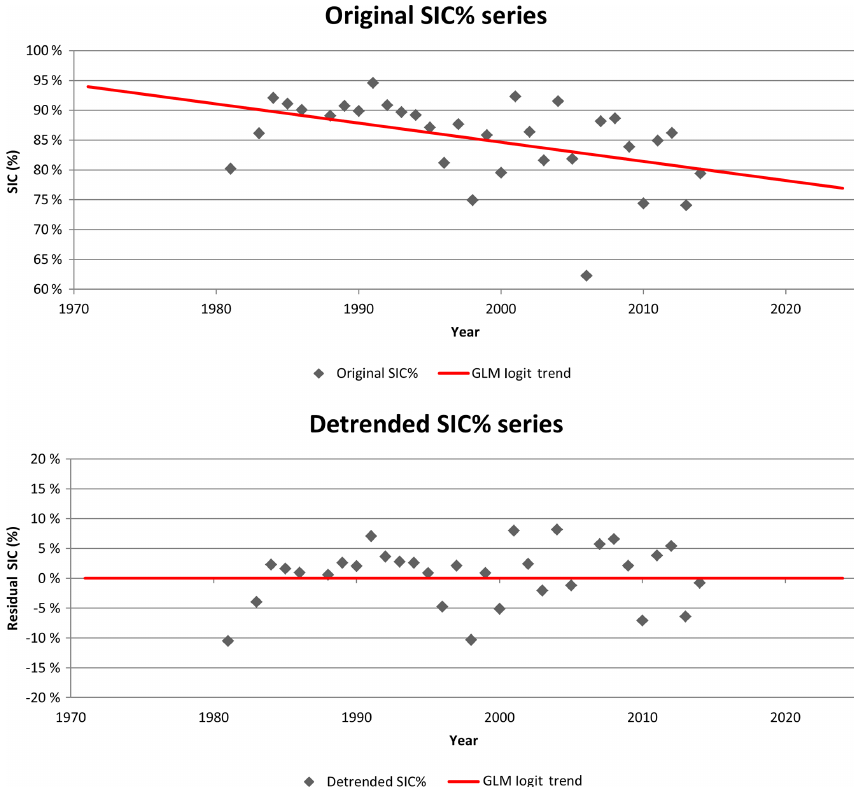
Figure 3. The trend removal process applied to a SIC% time series for a coastal grid cell extracted from OSI-409 data for week